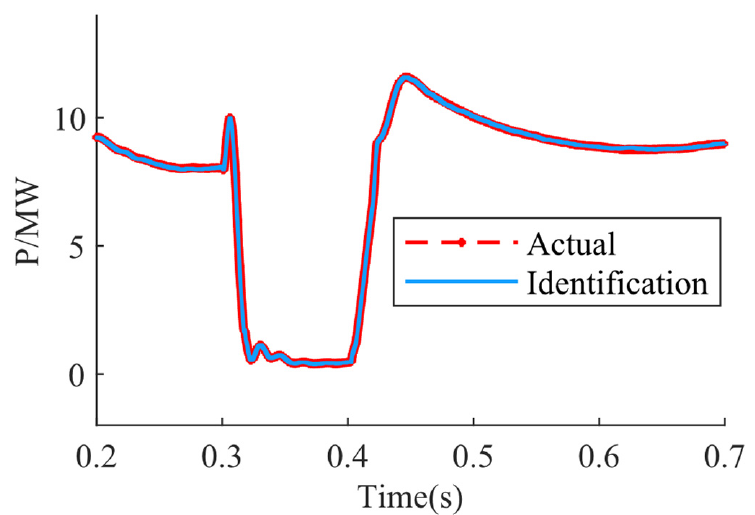
Figure 19. The active output of the actual model and the identification model.